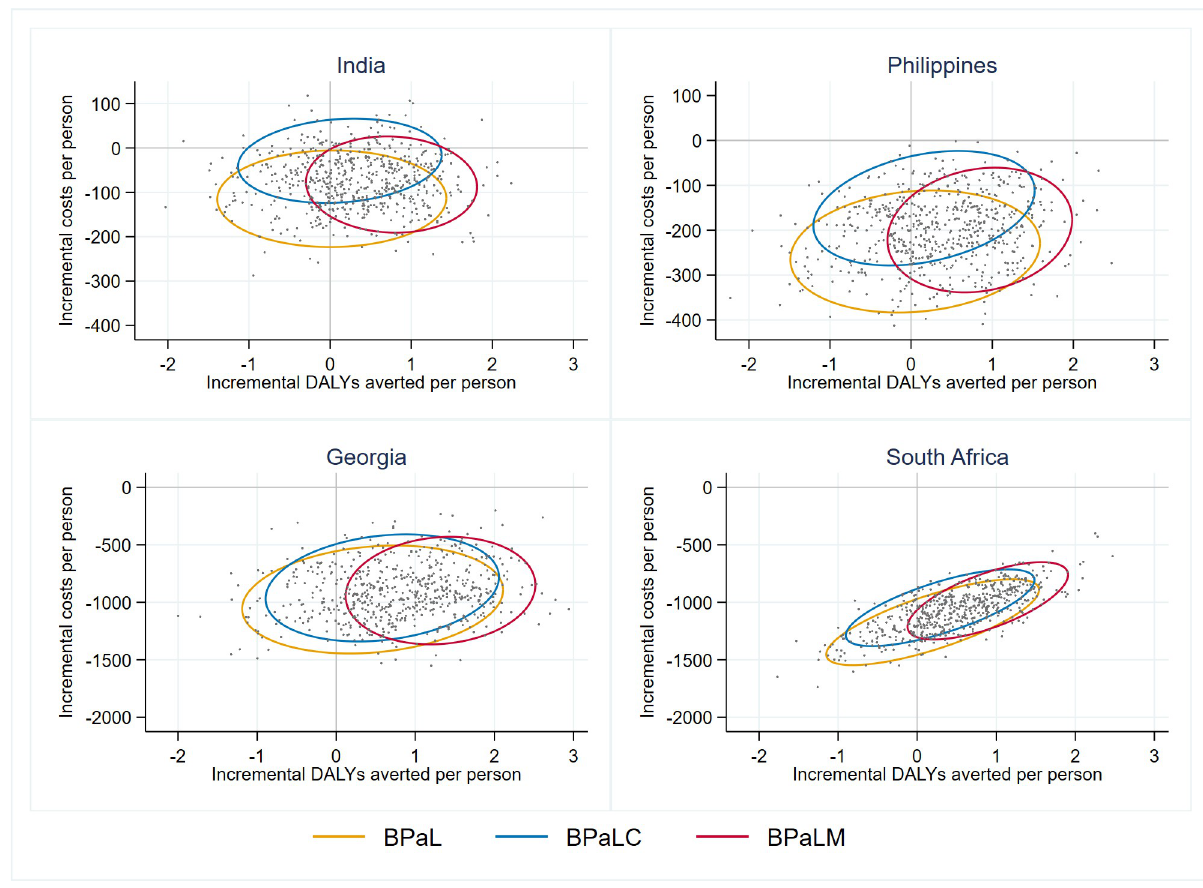
Fig 2. Probabilistic sensitivity analysis